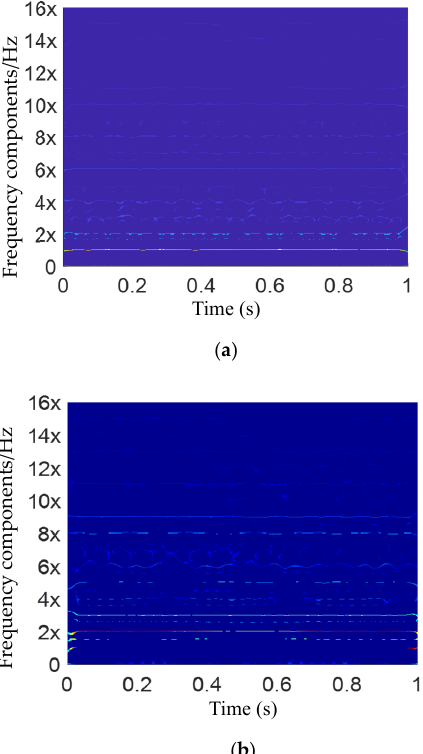
Figure 24. The SET for rubbing fault signals. ( a ) Slight rubbing ( b ) Serious rubbing